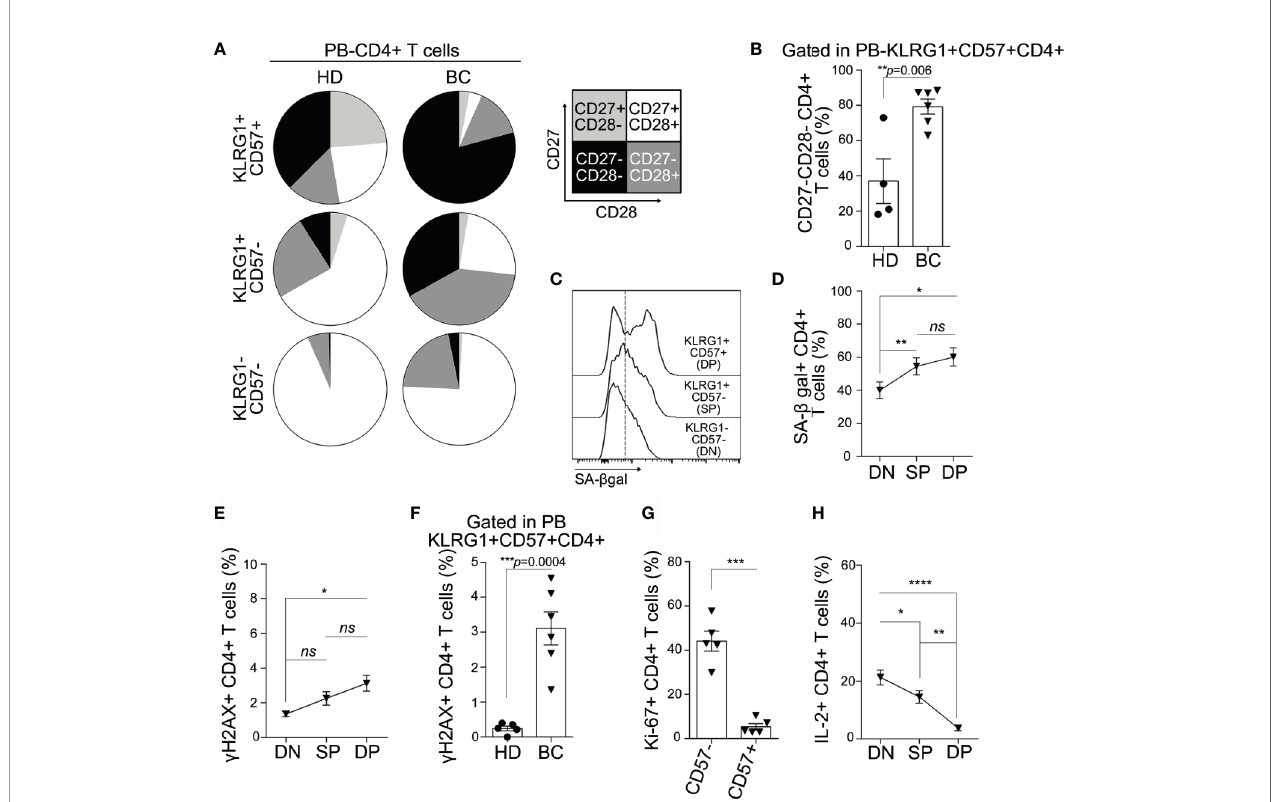
FIGURE 2 | KLRG-1 + CD57 + CD4 + cells from peripheral blood exhibit features of senescence. (A) Pie charts exhibit proportion of CD27 + CD28 + (white), CD27 + CD28 - (light gray), CD27 − CD28 + (dark gray) and CD27 − CD28 − (black) within CD4 + T cell subpopulations de fi ned by the expression of KLRG-1 and CD57, for all HDs and BC patients analyzed. (B) Bar graph shows frequency of CD27 − CD28 − cells within KLRG-1 + CD57 + CD4 + T cells from HDs (dots) and BC patients (triangles). (C) Representative histograms show the expression/activity of SA- b gal in KLRG-1 − CD57 − (DN), KLRG-1 + CD57 − (SP) and KLRG-1 + CD57 + (DP) CD4 + T cells from BC patients. (D) Mean frequency (± SEM) of SA- b gal + CD4 + T cells within DN, SP and DP subsets. (E) Mean frequency (± SEM) of g H2AX + cells in DN, SP and DP CD4 + T cell subsets. (F) Bar graph shows frequency of g H2AX + cells within KLRG-1 + CD57 + CD4 + T cells from HDs (dots) and BC patients (triangles). (G) Bar graph shows frequency of proliferating (Ki-67 + ) CD4 + T cells after stimulation and within CD57 − and CD57 + populations from BC patients. (H) Mean frequency (± SEM) of IL-2 + cells after PMA/Ionomycin stimulation in DN, SP, and DP CD4 + T cells. In all cases, each dot/triangle/square represents a subject analyzed. For two group comparisons (HD vs BC) unpaired Student ’ s t -tests were used in all cases ( p is indicated in each graph). For more three groups comparisons (DN, SP, and DP) matched one-way ANOVA and Tukey multiple comparison tests were used ( ns , not signi fi cant; *p < 0.05; **p < 0.01; ***p < 0.005; ****p <